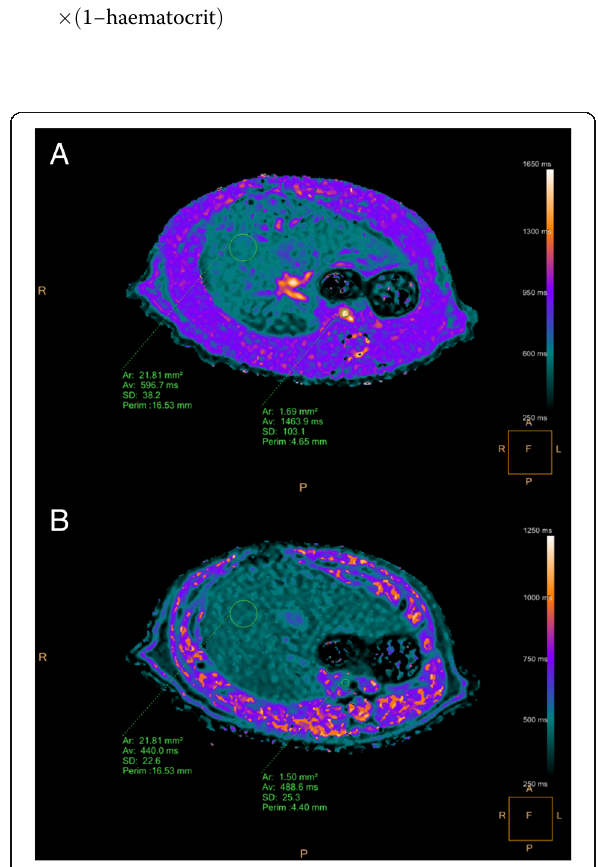
Fig. 1 Exemplary measurements of hepatic T1 relaxation times. Circular regions of interest are drawn in the right lobe of the liver and in the abdominal aorta. Measurements are given for pre- contrast ( A ) and 15 min post-contrast images ( B )